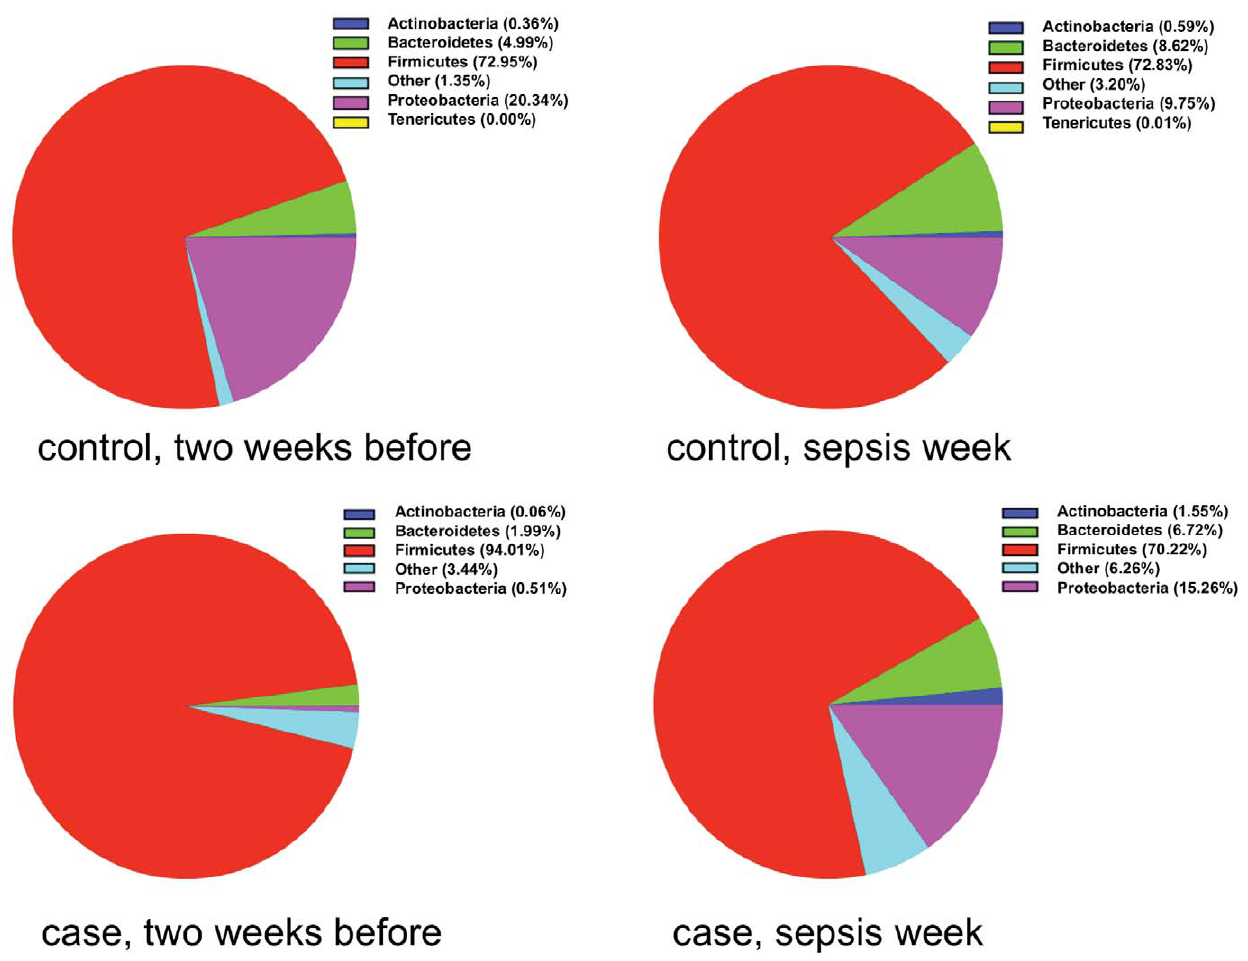
Figure 4. Changes in proportion of bacterial phyla. Proportions of the four major phyla 2 weeks before and within 72 hours of LOS diagnosis.